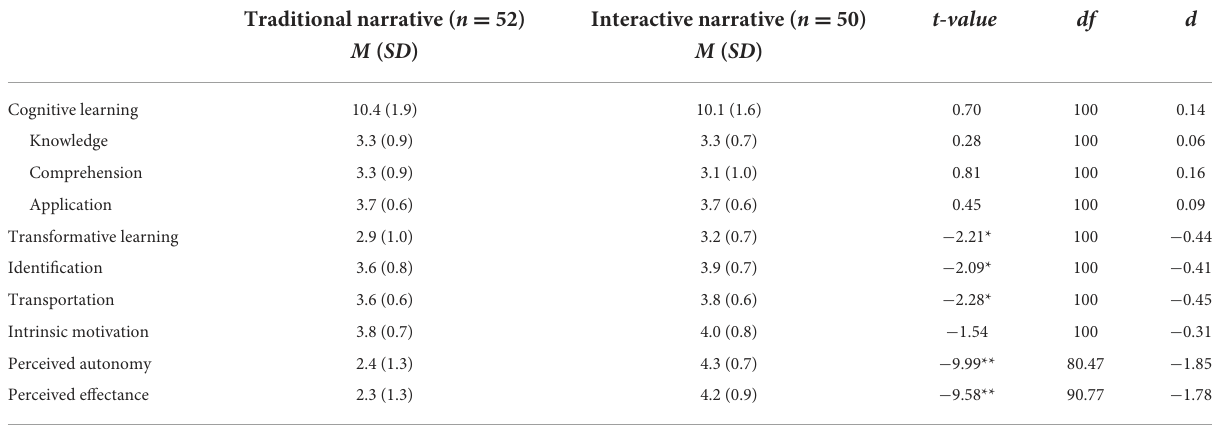
TABLE 3 Overview of descriptives, t -values, df ’s and effect sizes per condition for experiment 2. Traditional narrative ( n =